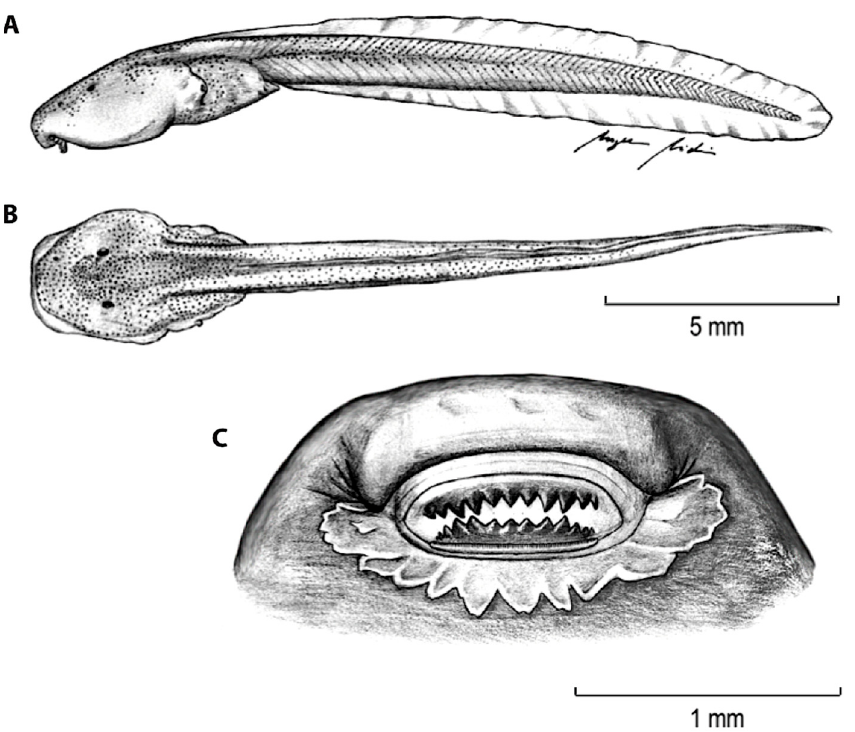
Figure 224. Tadpole of Vitreorana ritae at Gosner stage 25. ( A ) Lateral view. ( B ) Dorsal view. ( C ) Oral disc. Modified from Menin et al. [316].